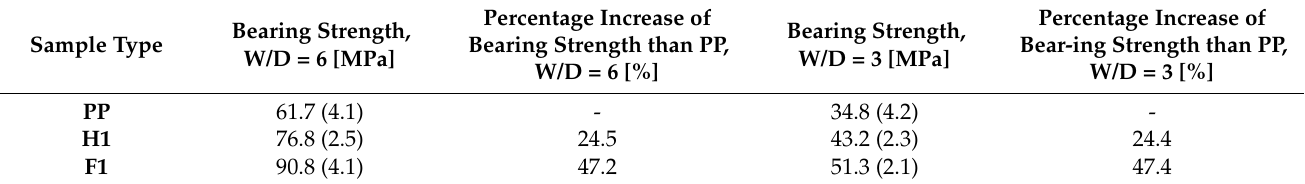
Table 4. Bearing strength, mean values and standard deviations (between brackets) of PP, H1 and F1 sample